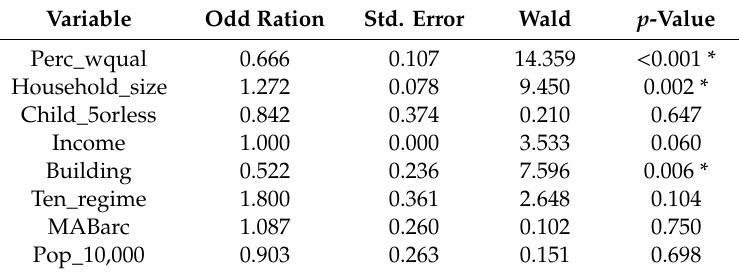
Table 5. Logistic regression model 2 results.